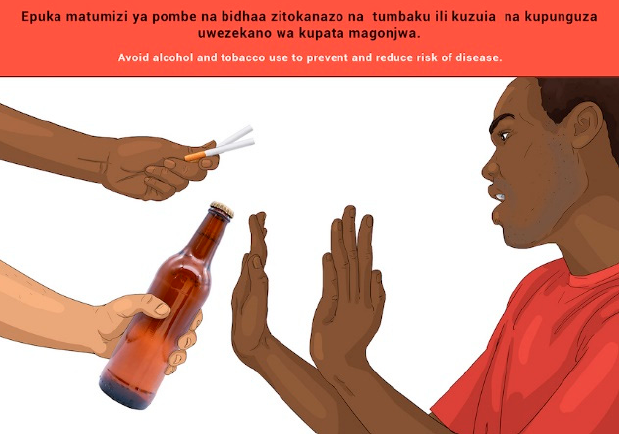
Figure 18. Avoid drinking alcohol and tobacco use to prevent and reduce risk of diseases. Participants articulated the meaning of both the message and the image very well.